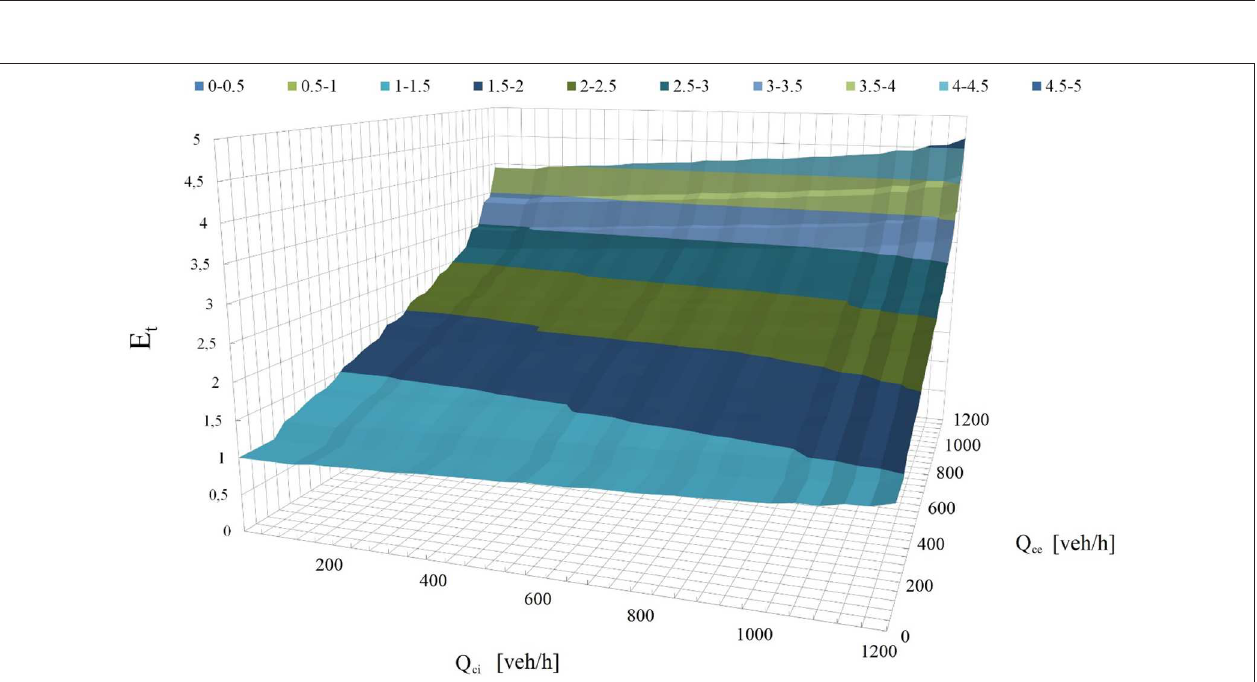
FIGURE 11 | PCE estimations for mean percentage of heavy vehicles between 10 and 20% for left entry lane at roundabout 2 (minor entries). E t , equivalent factor; Q ce , circulating flow on the outside lane [veh/h]; Q ci , circulating flow on the inside lane [veh/h].